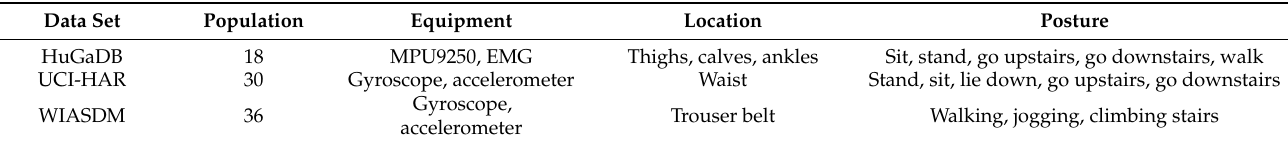
Table 1. Definitions of HuGaDB, UCI-HAR, and